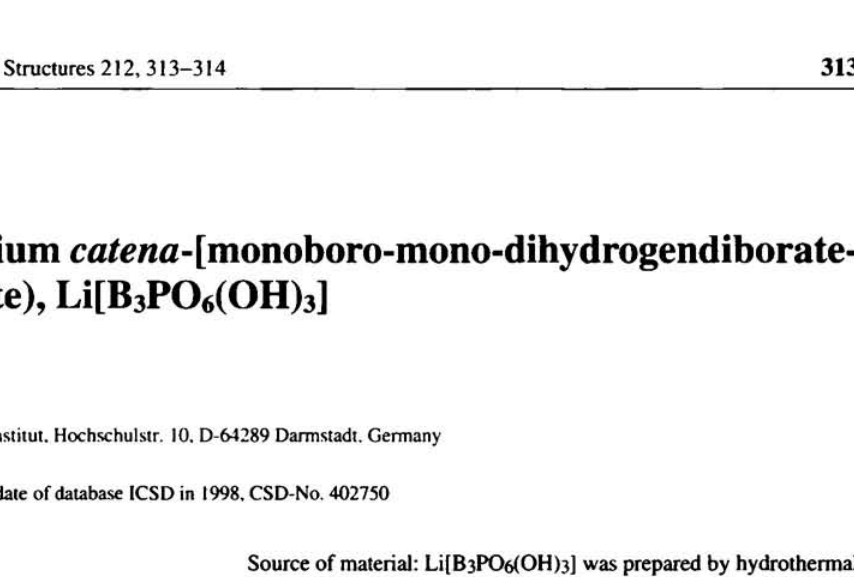
Table 1. Parameters used for the X-ray data collection